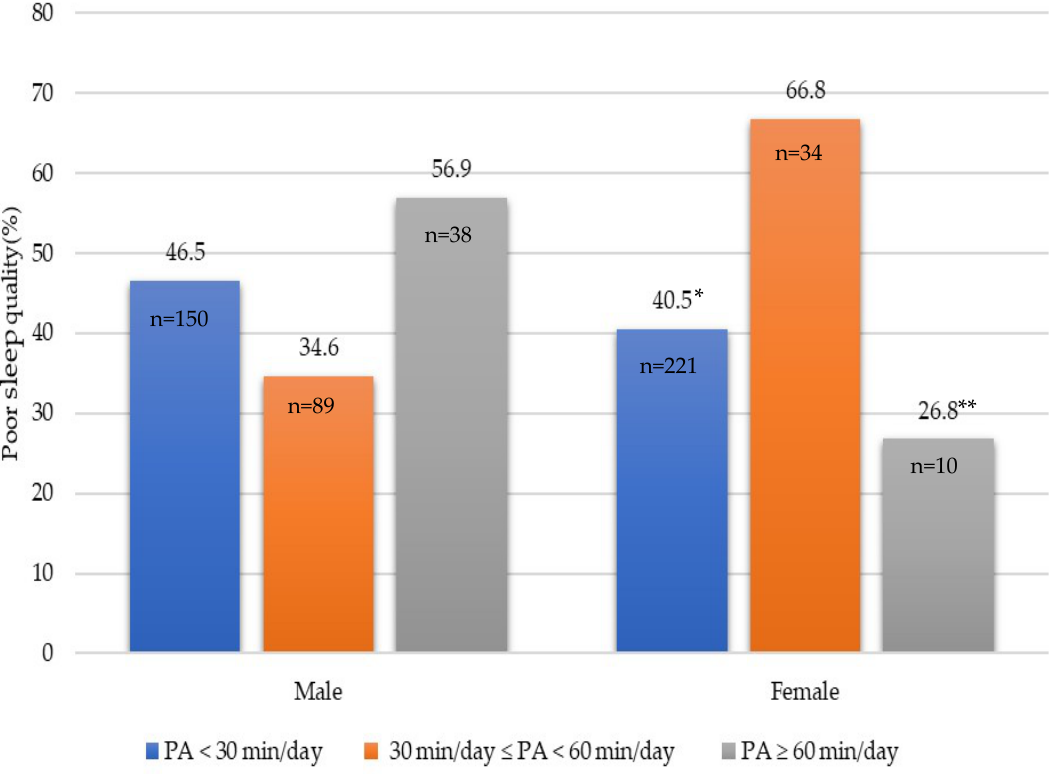
Figure 1. Poor sleep quality (%) and physical activity (PA) levels (min/day) in males ( n = 277) and females ( n = 265). Poor sleep quality was defined as needing 30+ min to fall asleep or reporting one or more sleep‐related problems in the past month; *PA <30 min/day different from 30 min/day ≤ PA <60 min/day, p = 0.049; ** PA ≥60 min/day different from 30 min/day ≤ PA <60 min/day, p = 0.003.